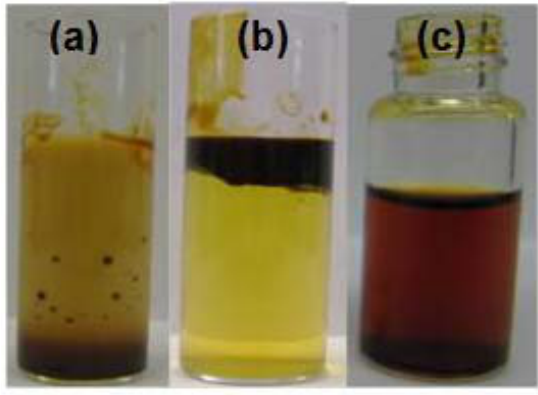
Figure 4. Miscibility of ( a ) crude bio-oil with water; ( b ) Upgraded bio-oil with water; ( c ) Upgraded bio-oil with hexane/toluene (Bio-oil was upgraded with a bio-oil/1-octene/ 1-butanol wt ratio of 1.5/0.6/0.75 at 120 °C after 3 h over